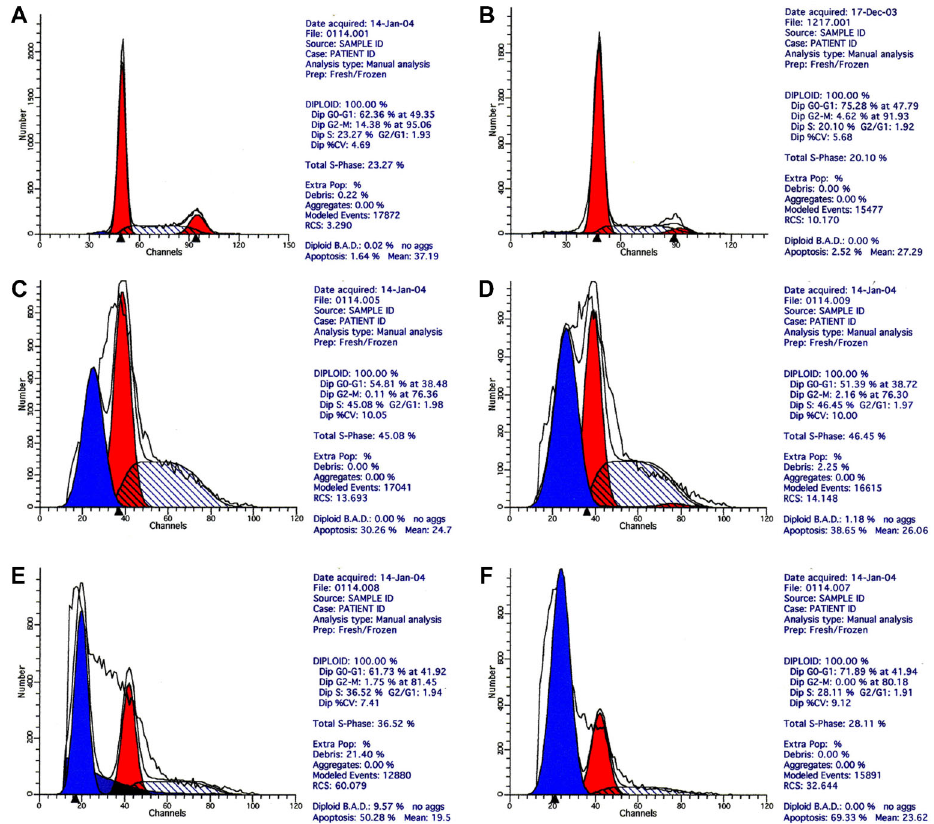
Figure 5. Flow cytometry of SMMC-7721 cells after treatment. A , Control group A (RPMI 1640 culture medium only); B , spiking group (8 g/L Fe 2 O 3 , no radiation); C , 2 g/L Fe 2 O 3 MFH group; D , 4 g/L Fe 2 O 3 MFH group; E , 6 g/L Fe 2 O 3 MFH group; F , 8 g/L Fe 2 O 3 MFH group. MFH: magnetic fluid hyperthermia.